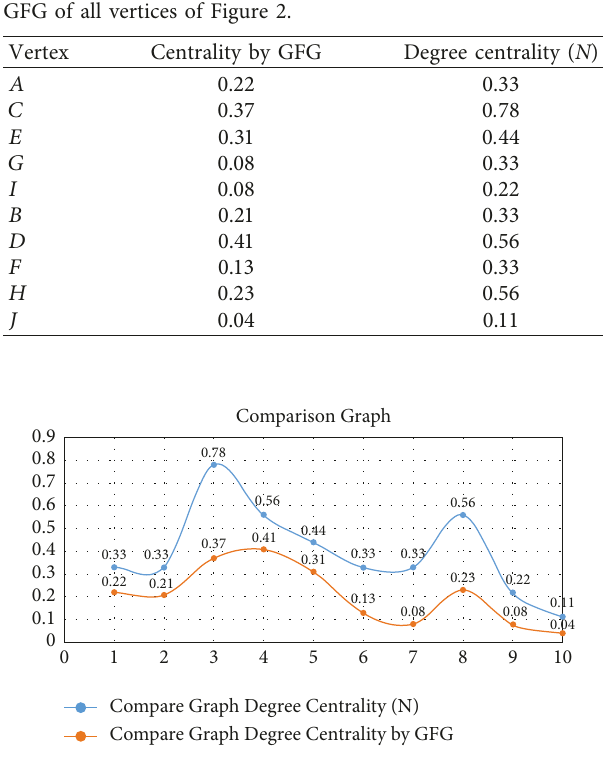
Figure 3: Comparison graph of degree centrality ( N ) and centrality by GFG of all vertices of Figure 2. Table 9: Degree centrality of all vertices of Figure 2. Vertex